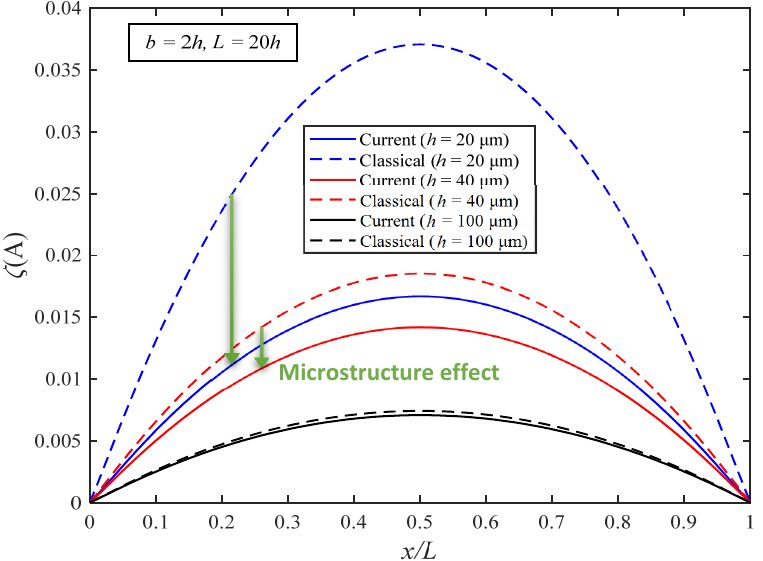
Figure 8. Magnetic potential of the MEE-FGM simply supported beam (Gradient index n = 5).